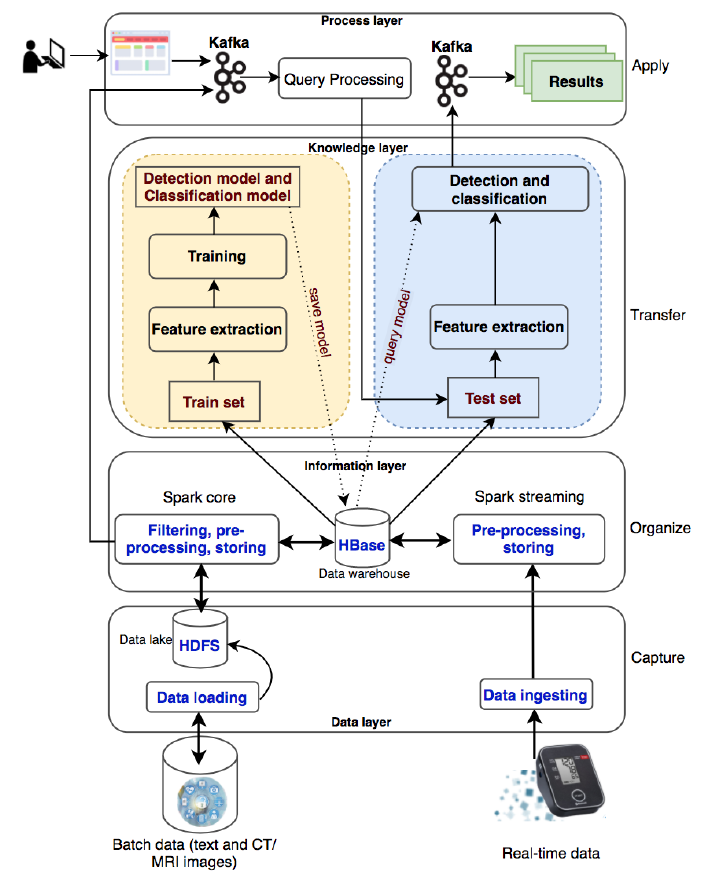
Figure 6. Proposed architecture for healthcare knowledge management